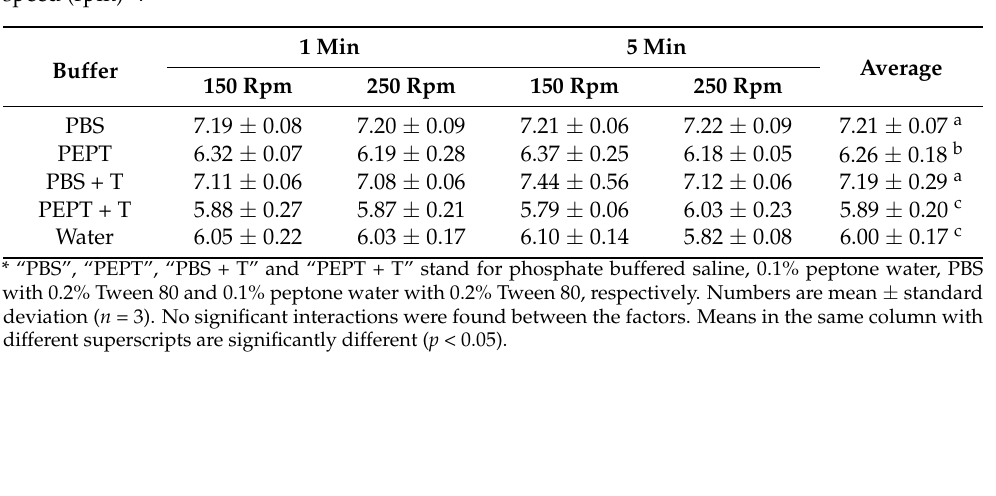
Table 3. pH of papaya skin homogenate as affected by homogenization buffer type, time (min) and speed (rpm)